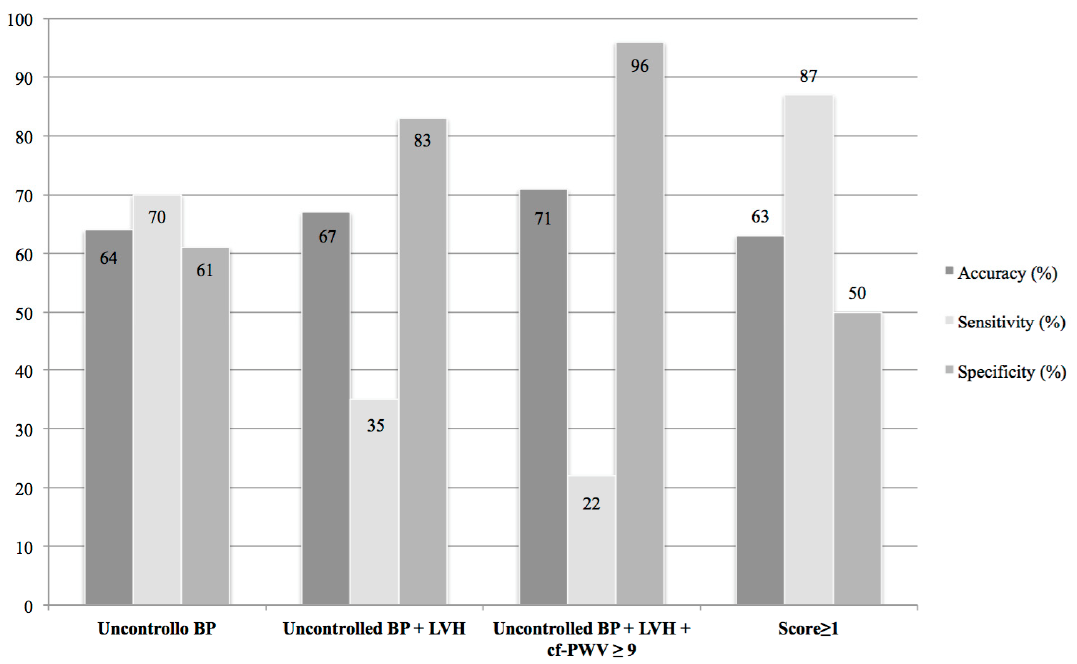
Figure 3. Sensitivity, specificity and accuracy of clinical and cardiovascular parameters. BP = blood pressure; LVH = left ventricular hypertrophy; cfPWV = pulse wave velocity; Score ≥ 1 = patients with 1 or more among BP ≥ 140/90, LVH, cf-PWV ≥ 9 m/s.